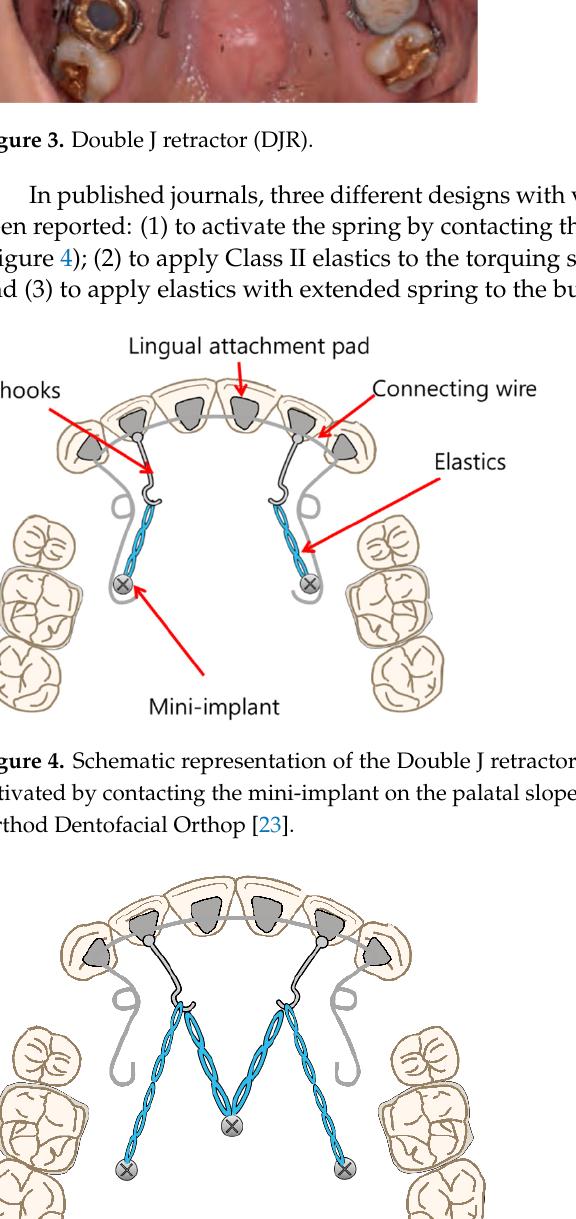
Figure 5. Schematic representation of a Double J retractor (DJR) designed to apply Class II elastics to torquing springs on a palatal slope. Redrawn with permission from Am J Orthod Dentofacial Orthop [14].